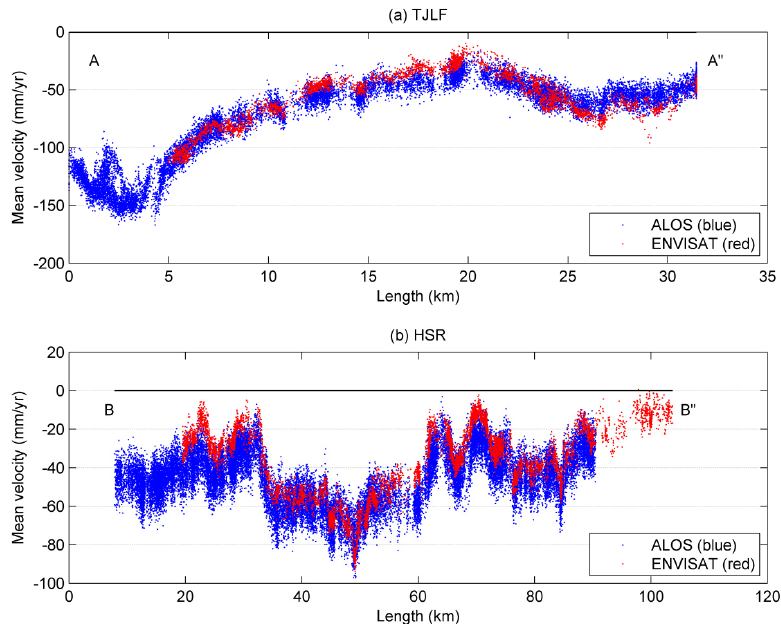
Figure 3. ( a ) LOS rates against longitude in TJLF swath with buffer distance of 500 meters to both sides of the line; and ( b ) LOS rates against latitude in a swath along the Jing-Hu High Speed Railway with buffer distance of 500 meters to the railway at both sides.